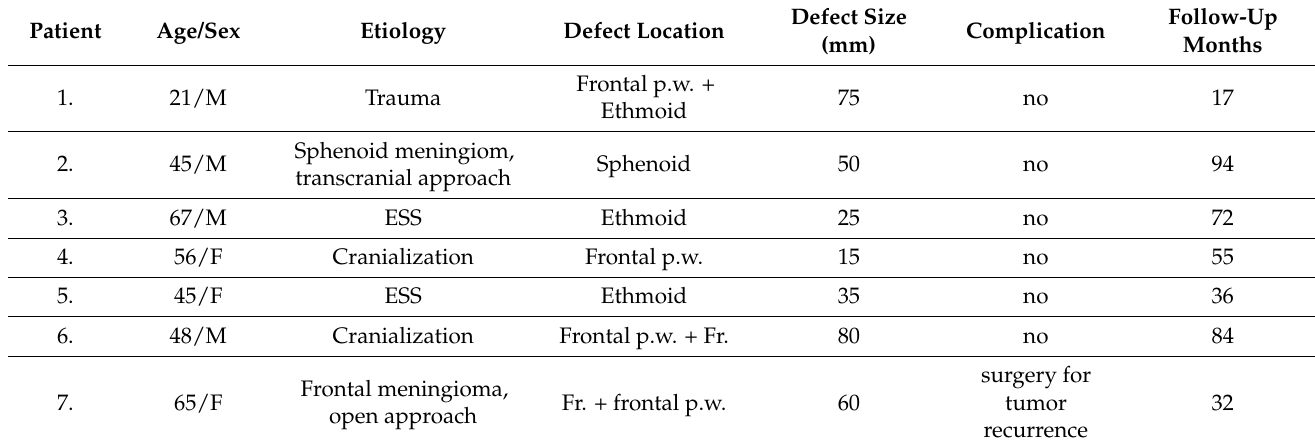
Table 1. Characteristics of patients included in the